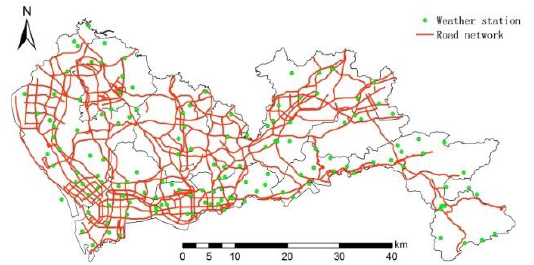
Figure 1. Spatial distribution of weather station and road network in